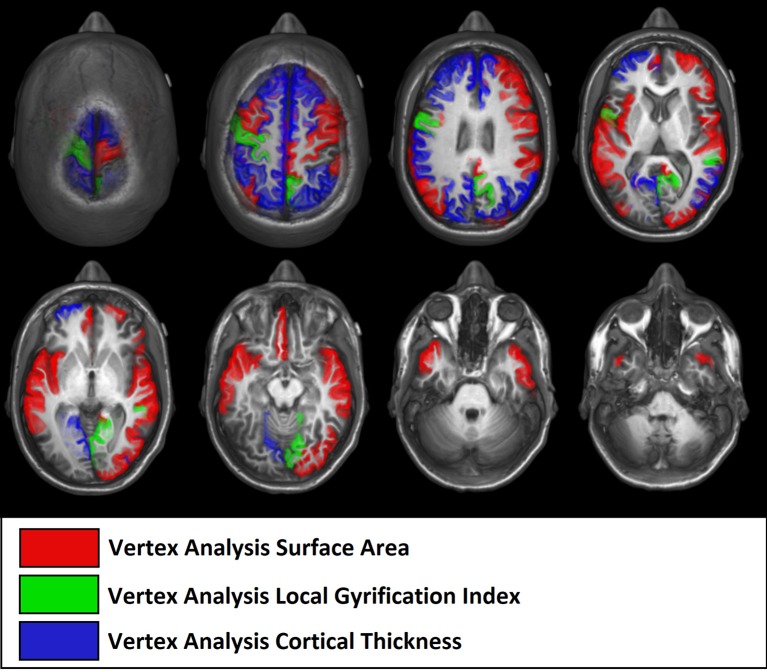
Illustrative figure showing anatomical localization of abnormalities of FreeSurfer vertex-wise analyses of surface area (in red), gyrification index (in green), and cortical thickness (in blue). The areas indicated in this figure do not correspond to the maximum voxel statistical location, but rather the sub anatomical regions with significant differences in patients with high functioning autism compared to controls. See Figure 3 and Table 4 for the location of maximal abnormalities and Table 8 for a summary of the location of increased and decreased changes as compared to controls.